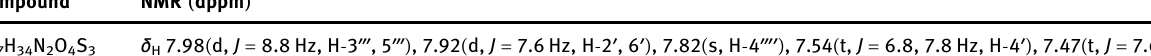
Table 1: 1 H - NMR spectrum ( 400 MHz, DMSO - d 6 ) of P - A Compound